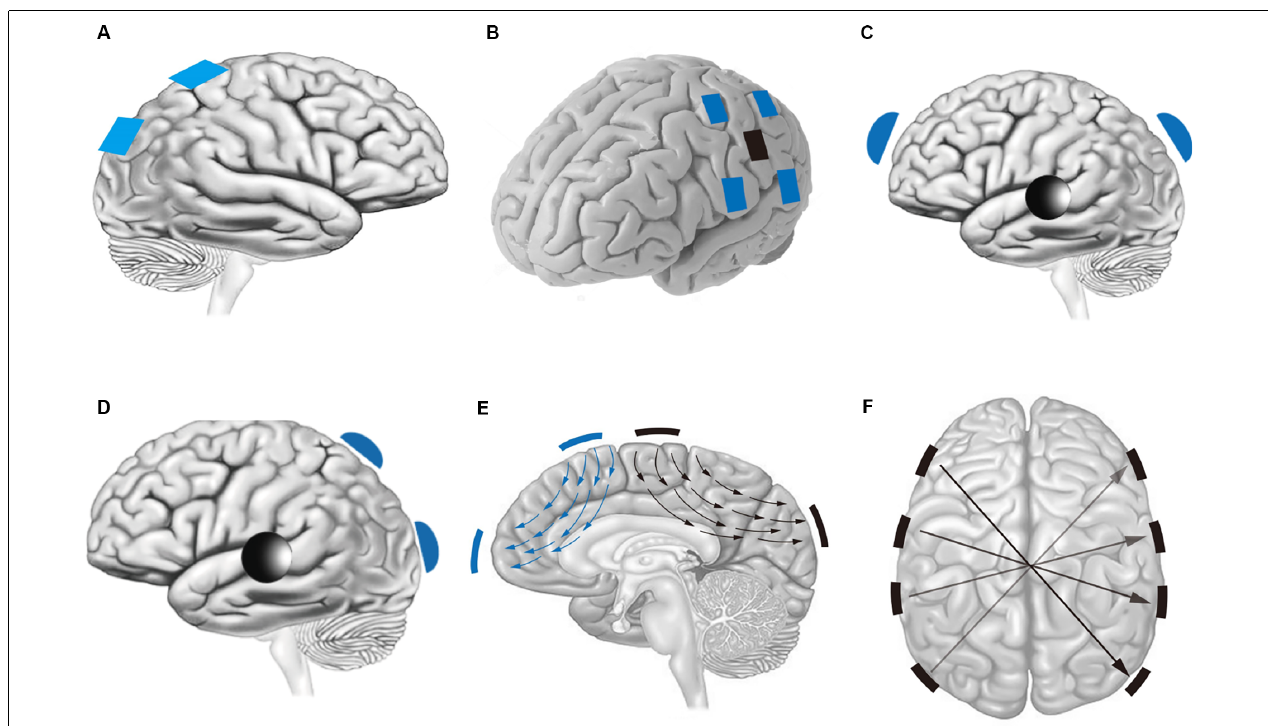
FIGURE 1 | (A) In traditional tACS, the position of the electrode is determined by the location of the stimulation. (B) HD-tACS; blue regions are the anodes, and the black region is the cathode. (C) Phase-shifted tACS; blue regions are the anodes, and the black region is the common cathode; the stimuli exerted by the two blue electrodes are only different in phase. (D) AM-tACS; blue regions are the anodes and the black region is the common cathode; the stimuli exerted by the two blue electrodes are, respectively, the envelope wave and the modulated wave. (E) Temporally interfering (TI) stimulation; the blue and black regions are two pairs of electrodes with different high-frequency electrical stimulations. (F) Intersectional short pulse (ISP) stimulation; a pair of electrodes at both ends of each arrow, and the stimulation time of each pair of electrodes is